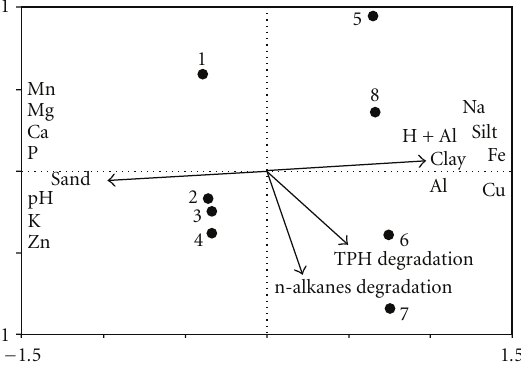
Figure 4: Ordination biplot displaying the first and second axis of a canonical correspondence analysis (CCA) using DGGE profiles (biological variables, open circles) and environmental variables (arrows) from Cantagalo and Panelas soils microcosms after 120 days of the bioremediation experiment. (1) MNA/Cantagalo, (2) MNAS/Cantagalo, (3) BE/Cantagalo, (4) BES/Cantagalo, (5) MNA/Panelas, (6) MNAS/Panelas, (7) BA/Panelas, and (8)